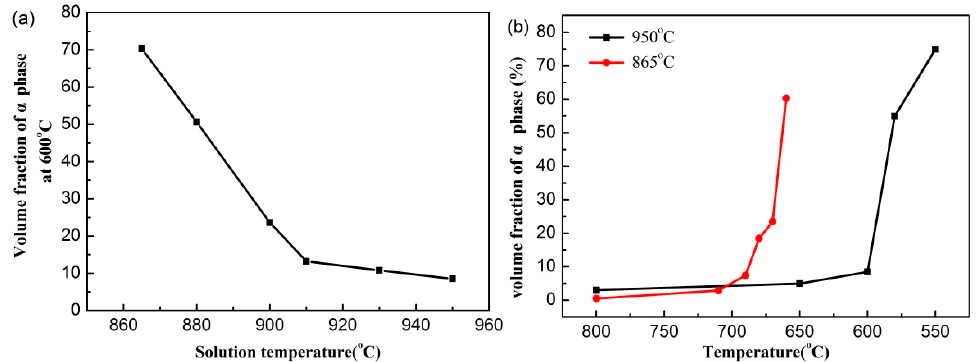
Figure 8. Effect of solution temperature on phase transformation during furnace cooling: ( a ) volume fraction of α phase at 600 °C; ( b ) phase transformation kinetics at different temperatures.